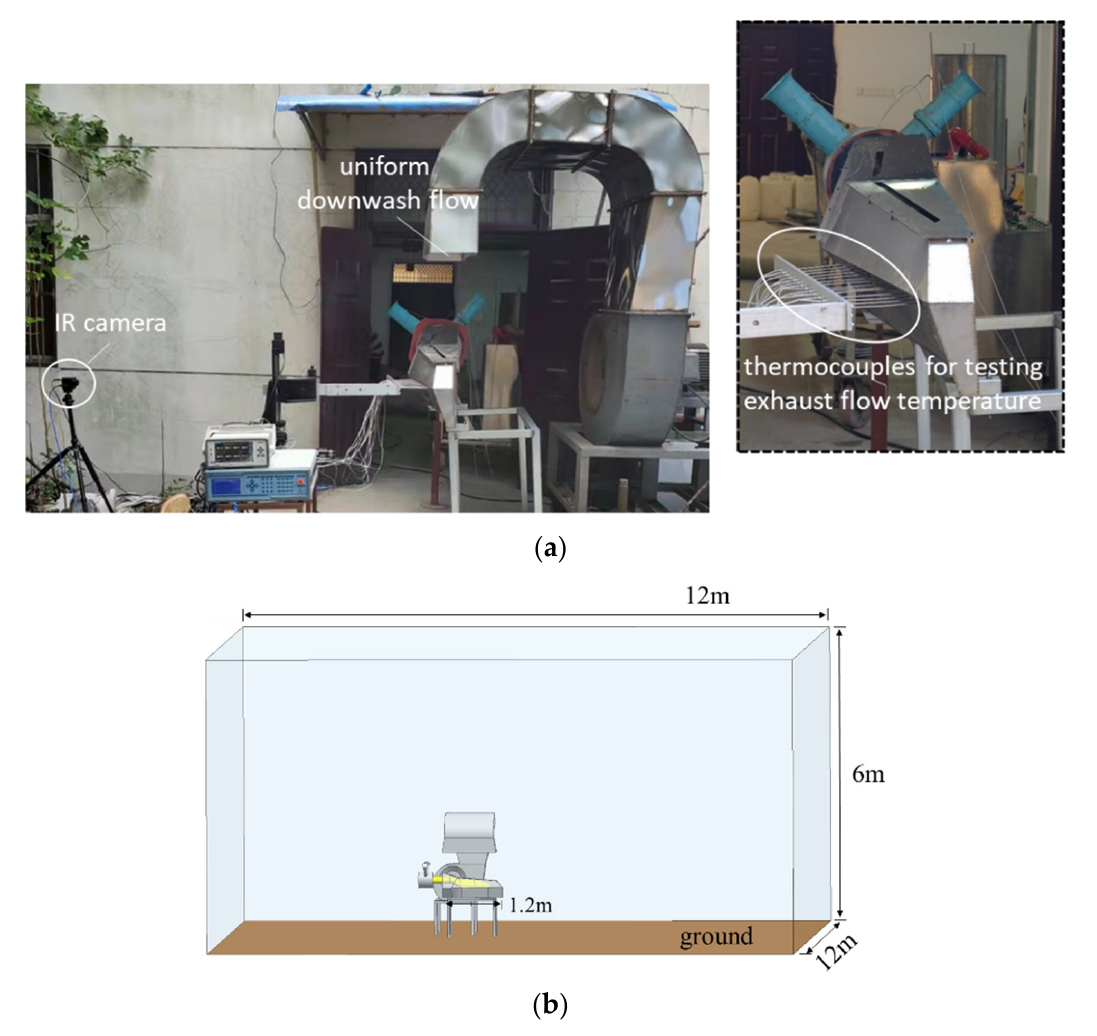
Figure 4. Schematic of ground test setup. ( a ) Experimental model. ( b ) Numerical simulation model.